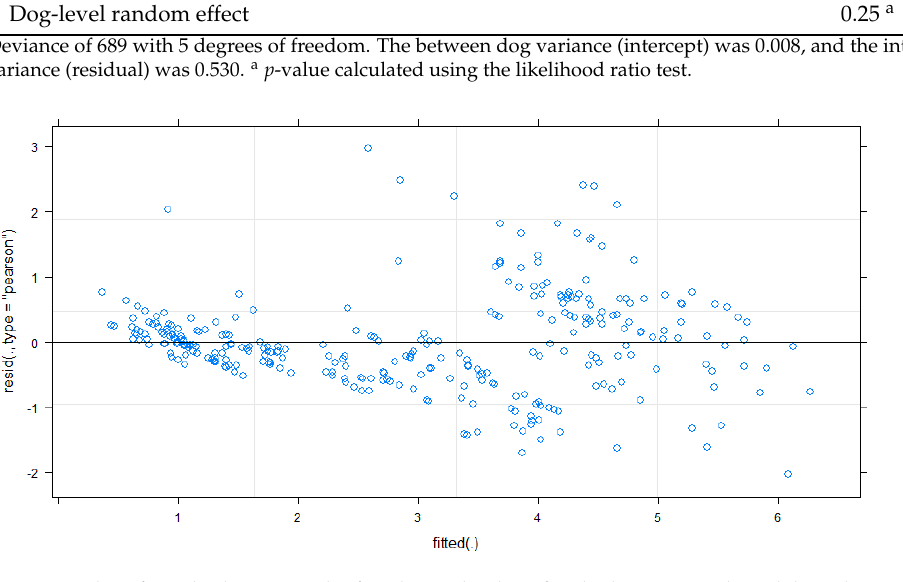
Figure 6. Plot of residuals against the fitted speed values for the linear mixed model predicting speed with delta-G and skeletal size, with dog as a random effect.